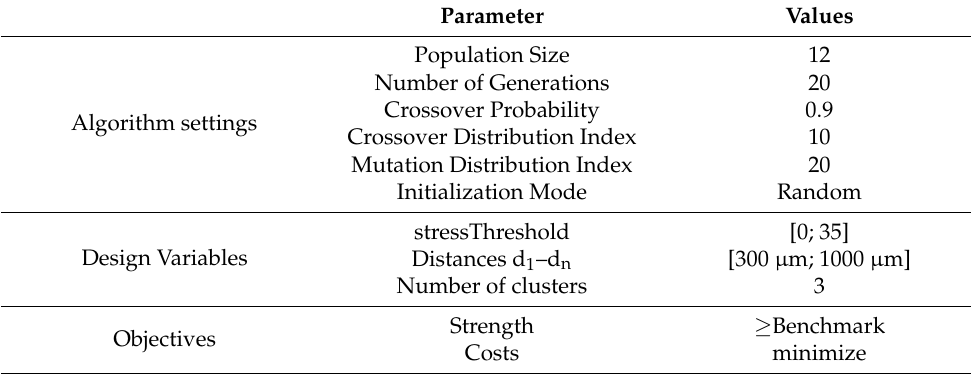
Table 3. Optimization settings for NSGA-II, design variables, and objectives.